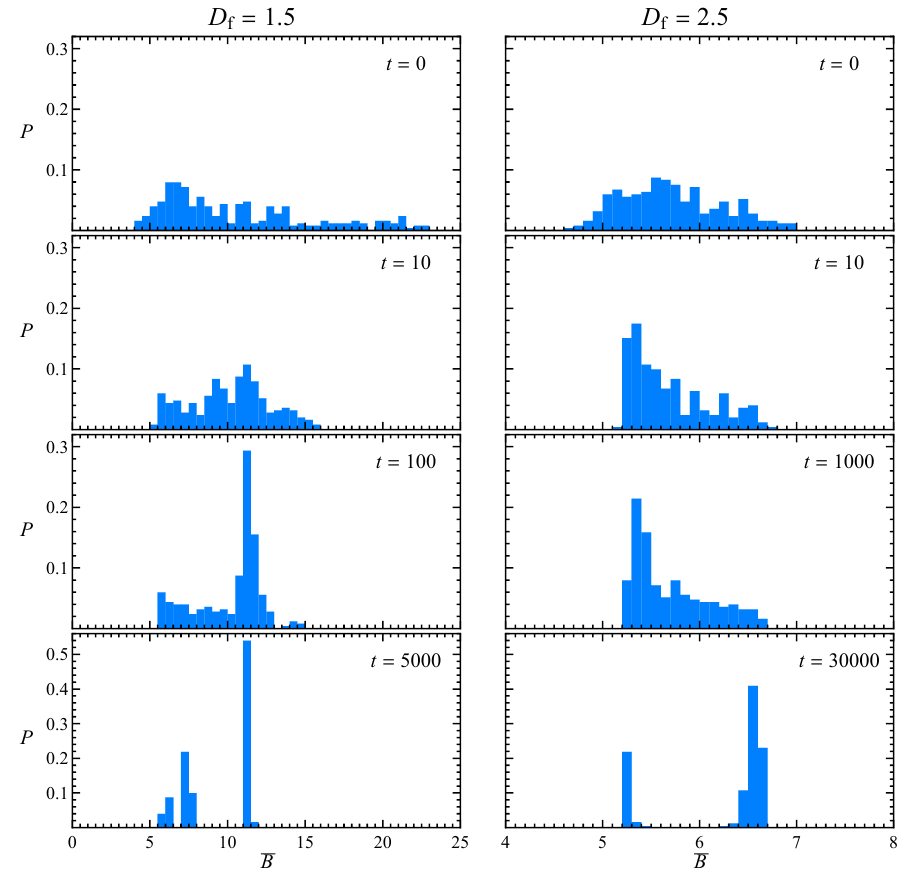
Figure 7. Probability distribution of the time-average intrinsic viscosity B corresponding to the initial aggregate orientations used to build the look-up table and n = 1.0, for low ( left ) and high ( right ) fractal dimension, parametric in